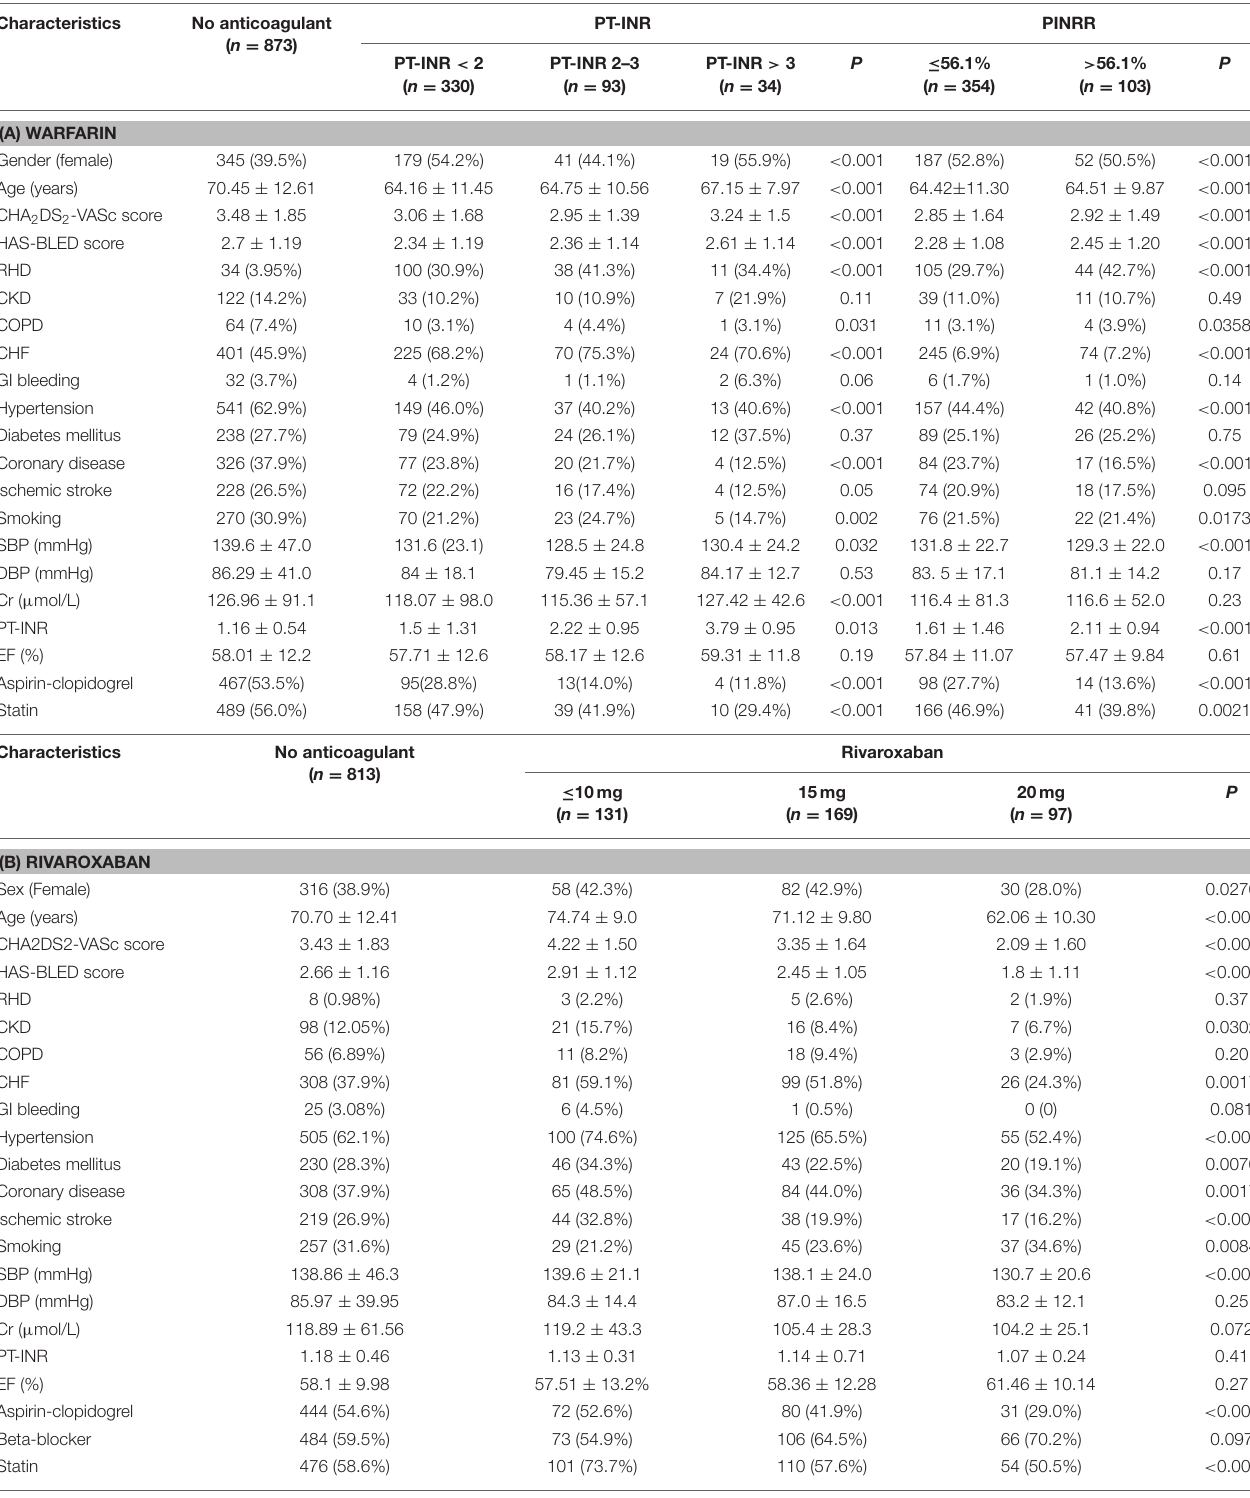
TABLE 1 | Baseline characteristics of enrolled patients (A) warfarin and (B) rivaroxaban.